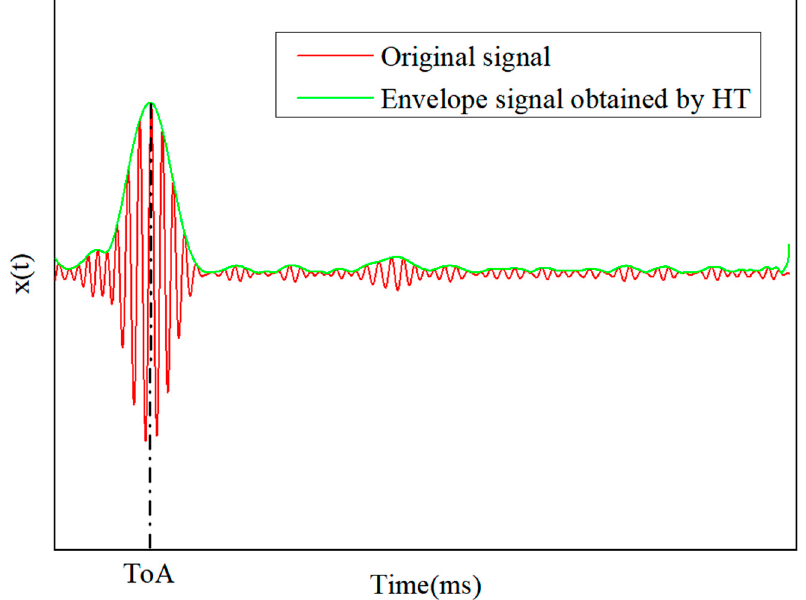
Figure 2. Schematic diagram of a Hilbert transform (HT) for the envelope signal.